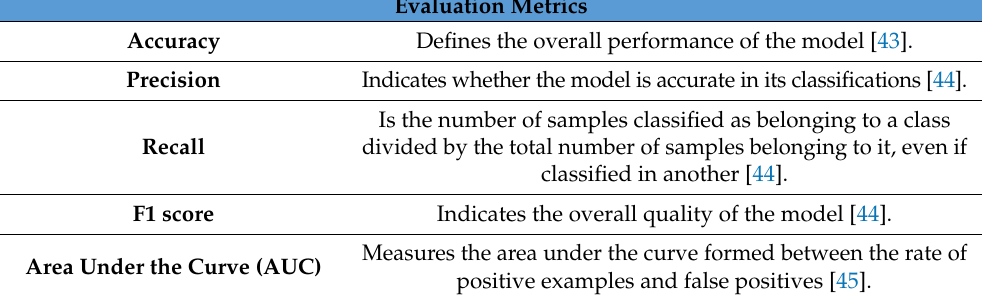
Table 4. Evaluation